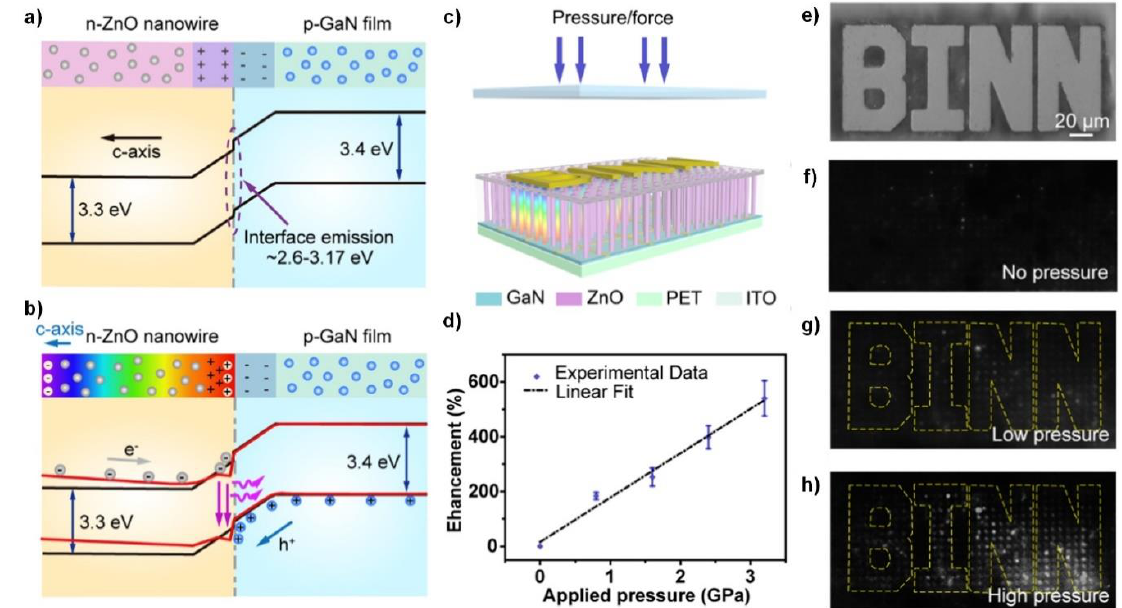
Figure 5. Piezophototronic-effect-assisted piezoelectric pressure imaging devices. ( a , b ) Energy band edge diagram of n-ZnO–p-GaN heterojunction before ( a ) and after ( b ) encountering compressive strain. ( c ) Device structure and strategy of selective pressure application. ( d ) Relationship between the enhancement factor E and the applied pressure. ( e ) Optical image of the sapphire seal used in measurements. ( f – h ) Electroluminescence images of the device at ( f ) zero, ( g ) low, and ( h ) high pressures, respectively. Reproduced from [38] with permission from Elsevier Limited. Copyright